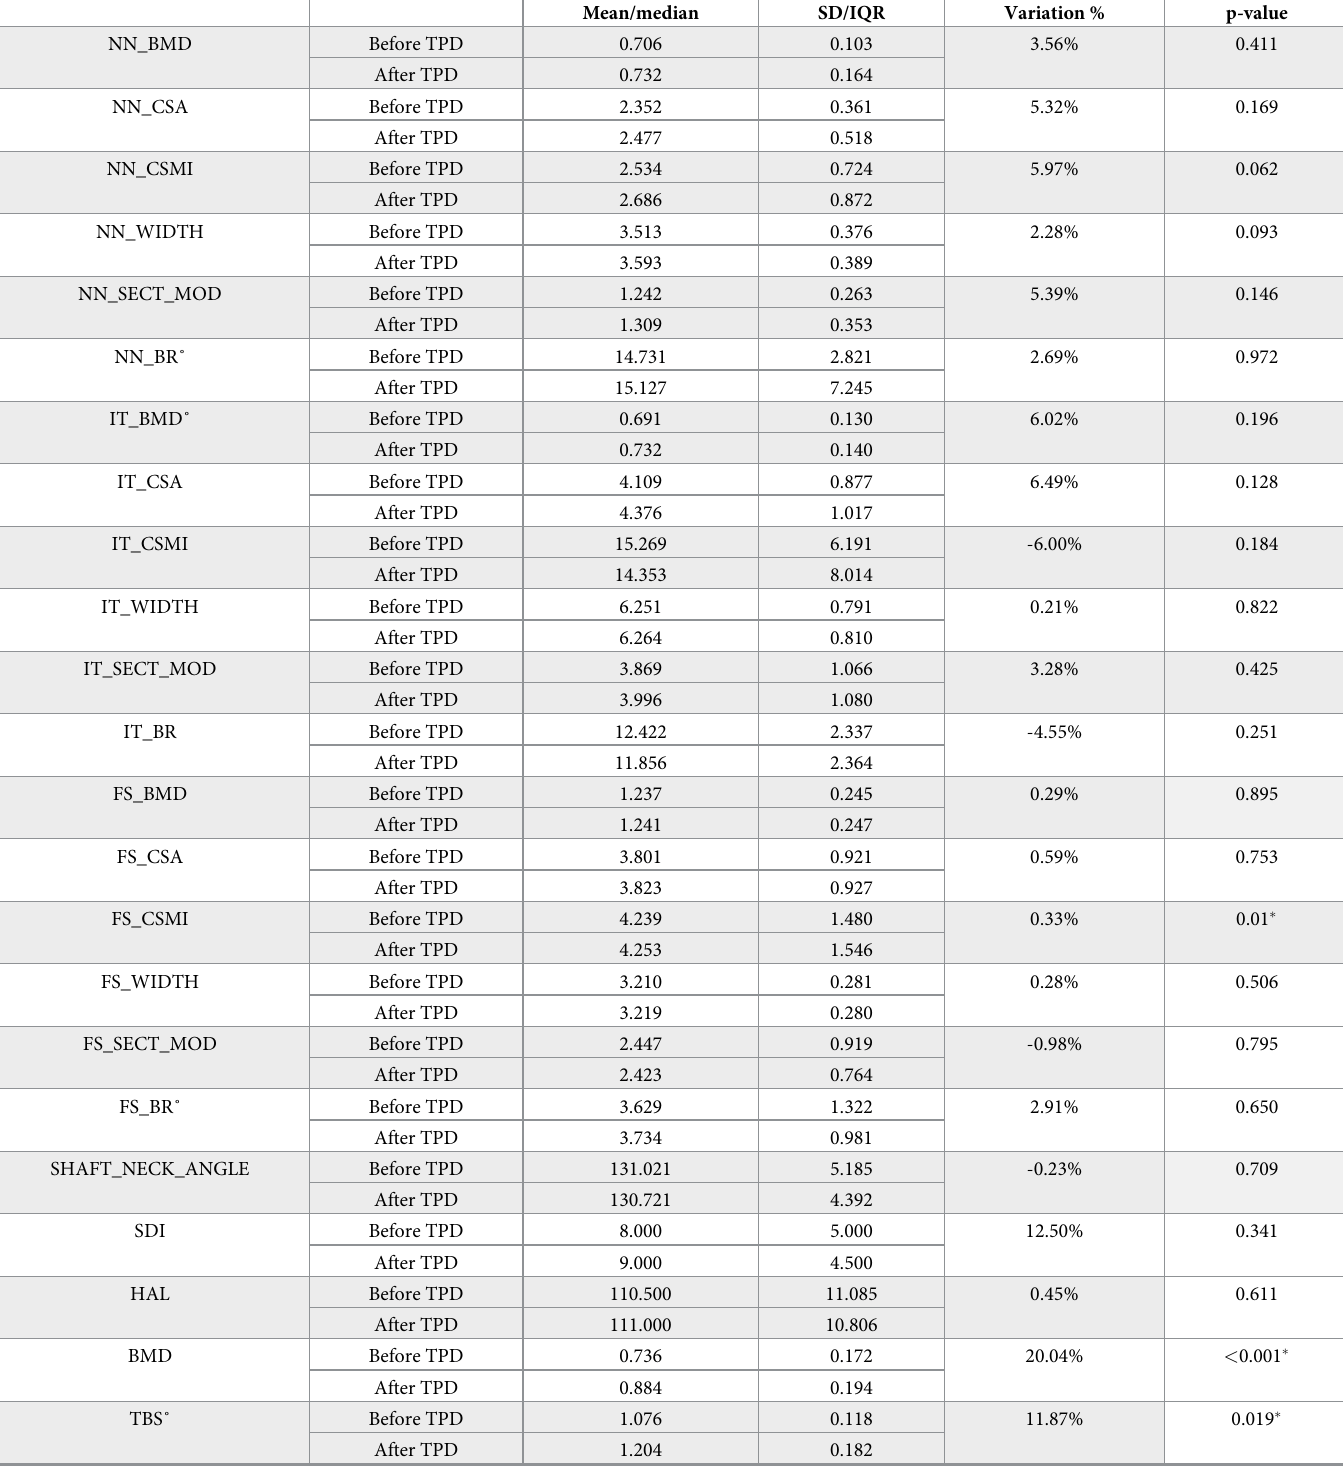
Table 2. SDI and DXA parameters of the “responders” (14 patients; 8 females and 6 males) before and after TPD